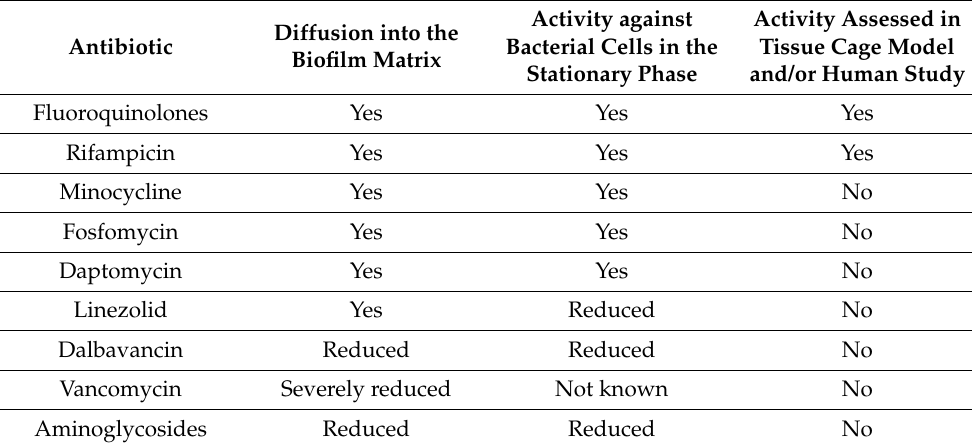
Table 1. Activity of different antibiotics against biofilm-related infection (modified from Ref. [22]). Antibiotic